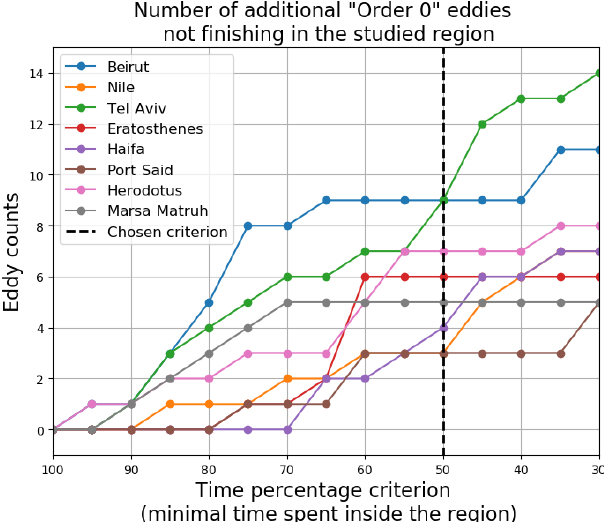
Figure A1. Sensitivity of the total number of order 0 anticyclones with the lifetime criterion, for four chosen regions: “100%” means that order 0 anticyclones are strictly the ones dying in the study region; “30%” means that order 0 are dying in the study region as well as anticyclones that spend 30% of their lifetime within the borders of this region. A value of 50% is chosen in this study (see Table A2).